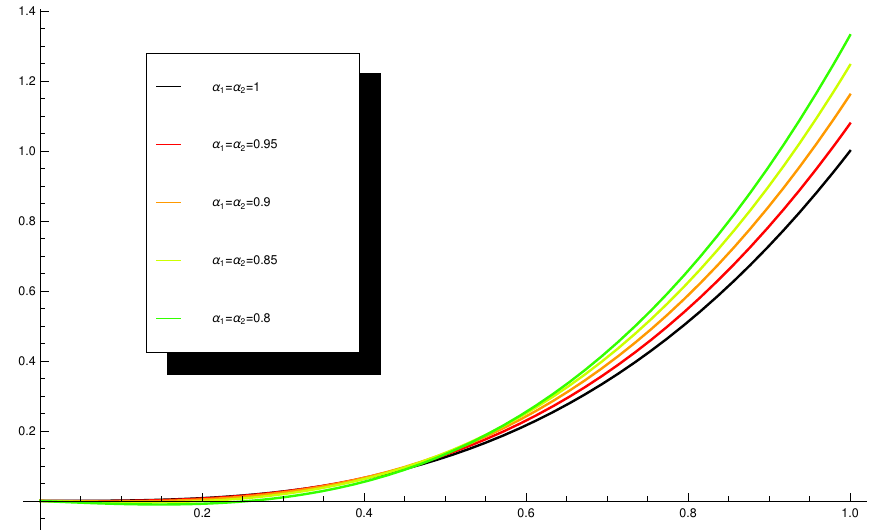
Figure 9. Approximate solutions x 3 of (20) for several values of α 1 and α 2